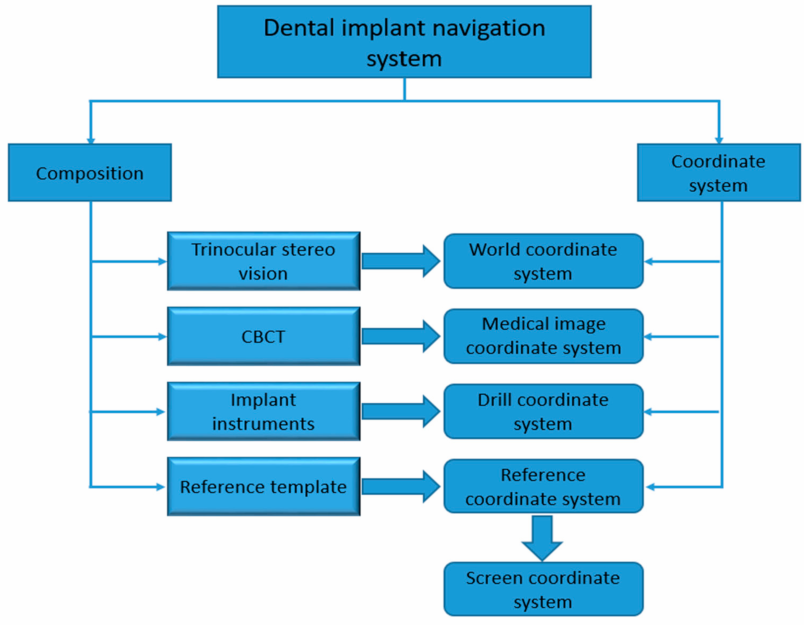
Figure 2. The relationship between hardware composition and the coordinate system of DINS.